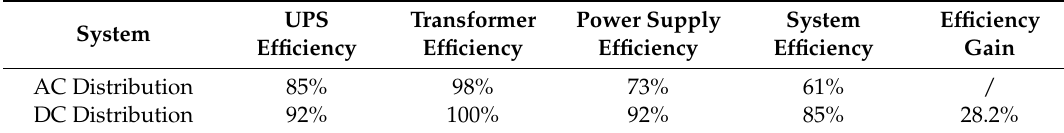
Table 3. System efficiency of the AC and DC distribution system.